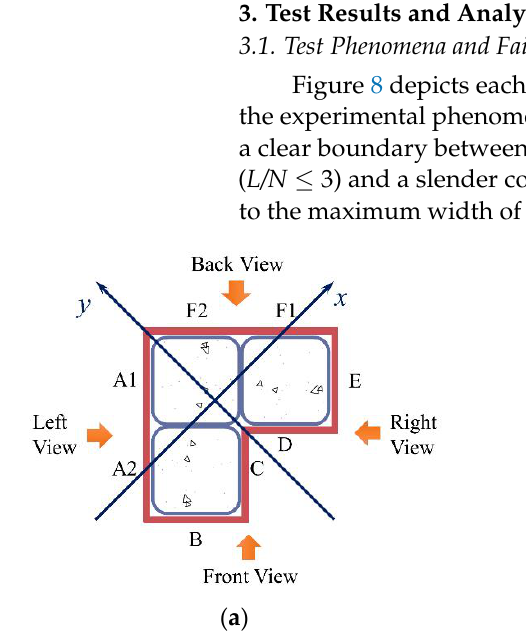
Figure 8. Numbering and view orientation of each surface. ( a ) L-shaped; ( b ) T-shaped.